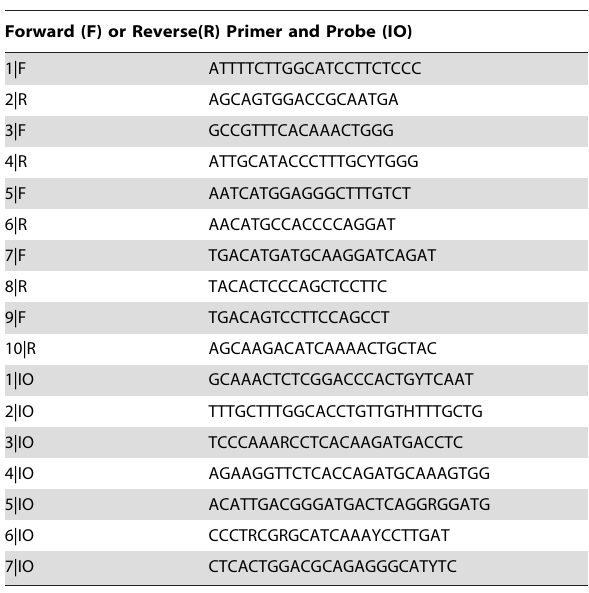
Table 3. Primer and probe (IO) sequences for RVFV run with all segments in a single input